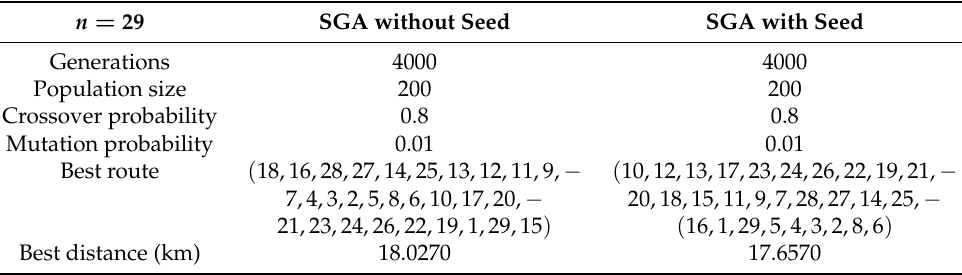
Table 7. Results of the n = 29